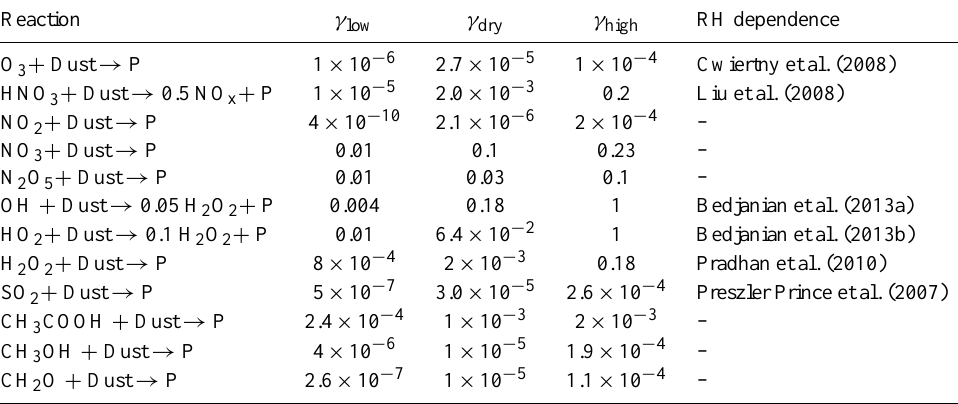
Table 1. The heterogeneous reactions and dry reactive uptake coefficients ( γ dry ) used in this study are listed. γ low and γ high represent lower and upper bounds of reactive uptake coefficient reported in the literature. The rightmost column shows the references based on which relative humidity dependence of γ dry is